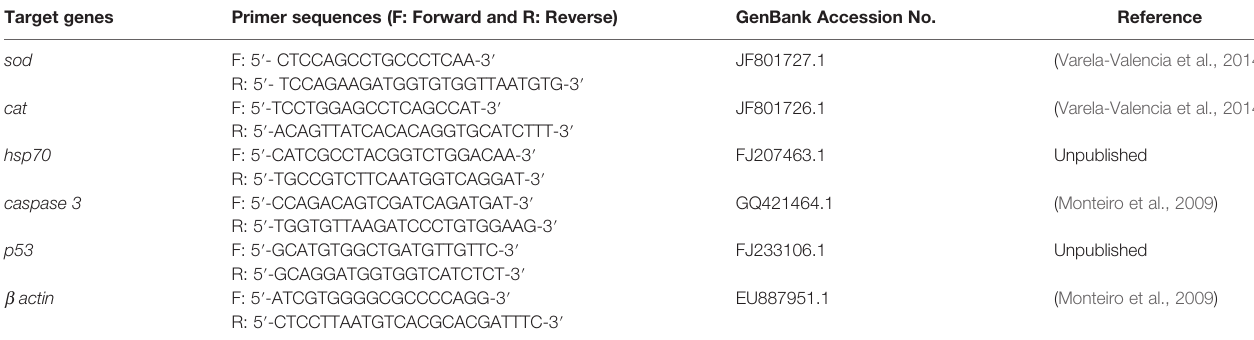
TABLE 1 | Primers sequences of Oreochromis niloticus target genes used in the real-time quantitative PCR study. Target